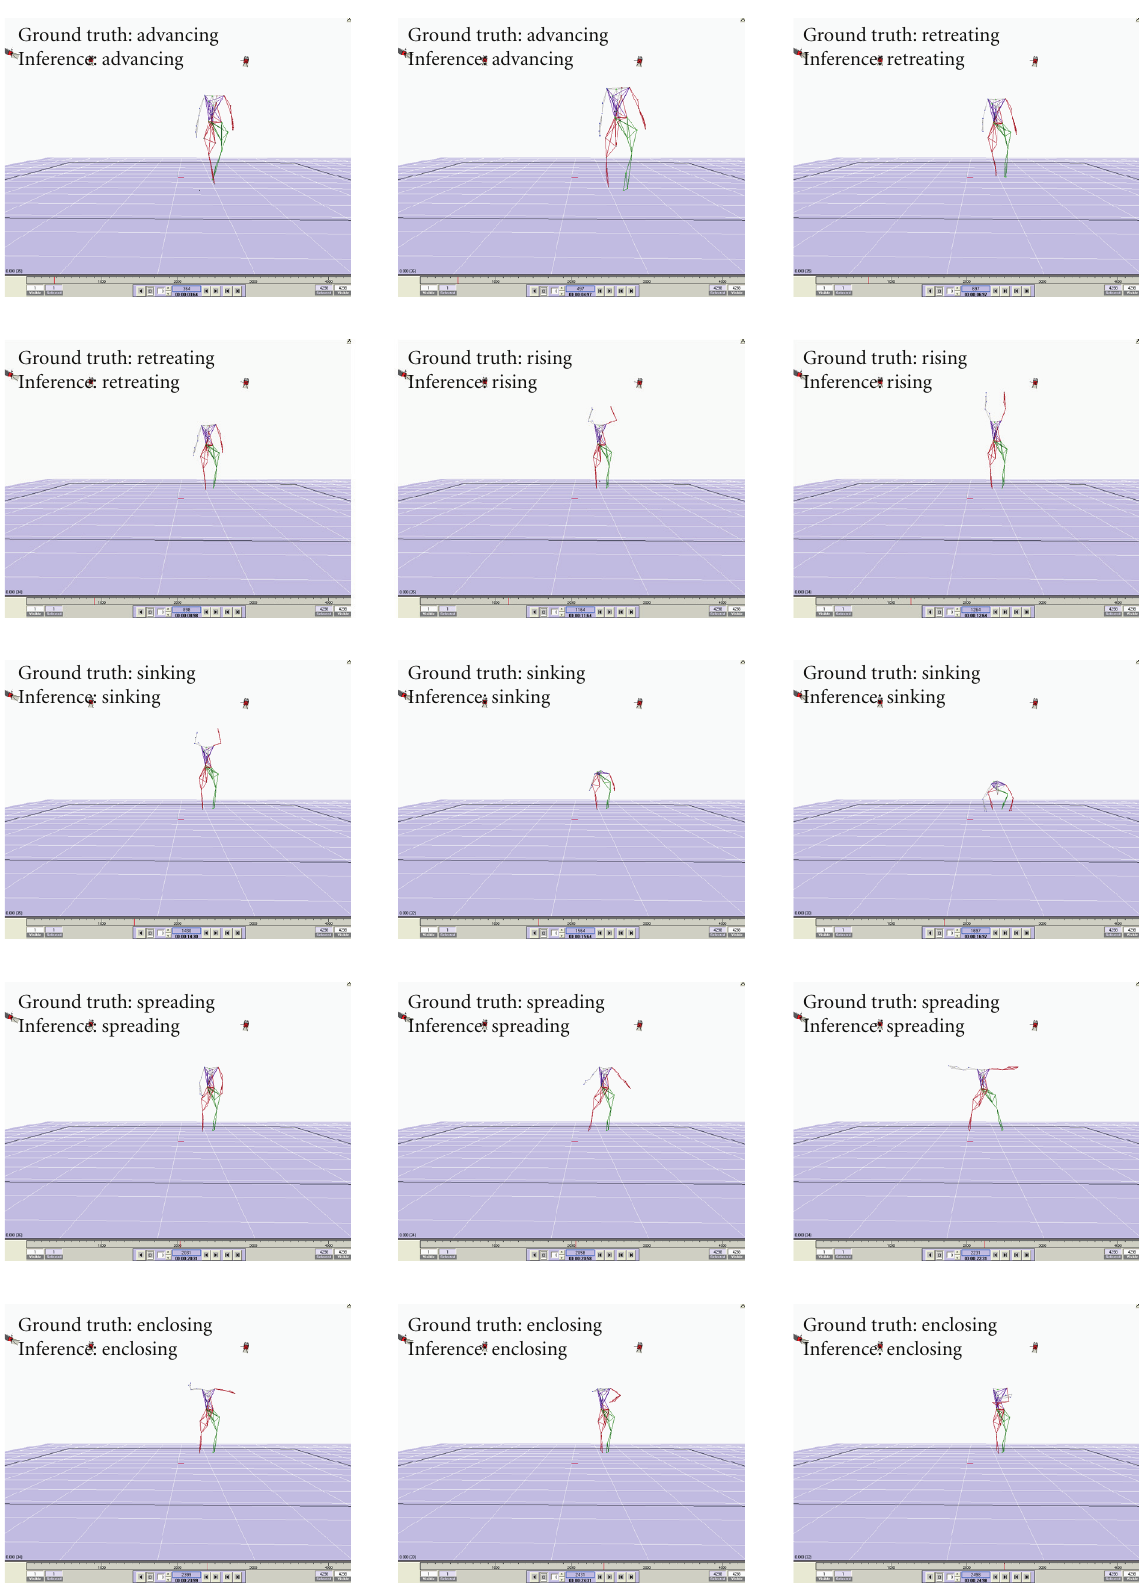
Figure 9: Image sequence of “Menu 1” (dancer 1) movement data showing the ground truth and inference results of the dominant Shape quality